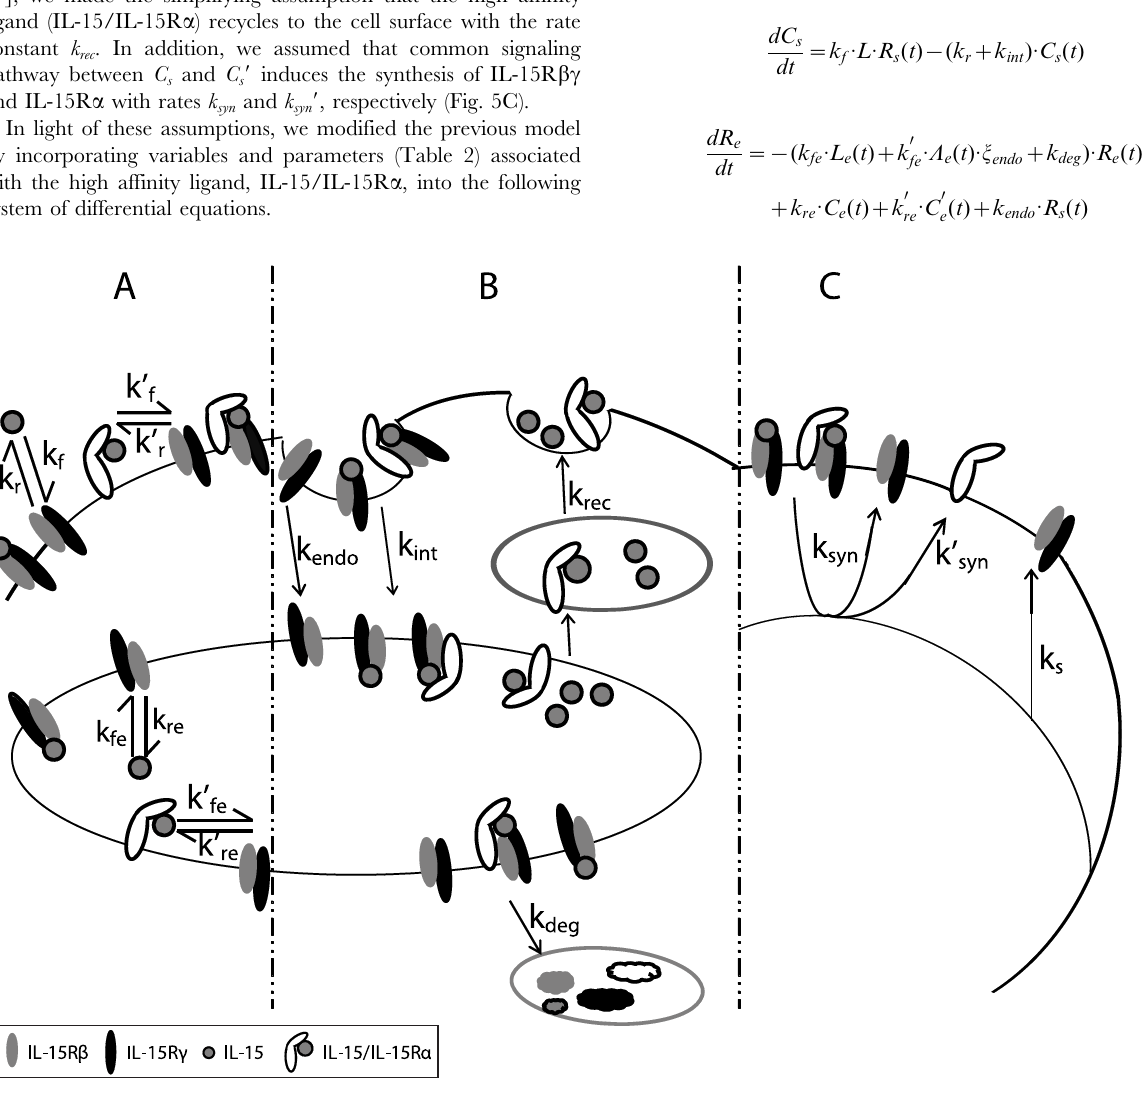
Figure 4. The quantitative influence of intermediate affinity binding model parameters on the steady state cell surface receptor and complex numbers. Model simulations were performed with the value of the parameter of interest varied by a factor of 1 and 100, while the values of all other parameters were held constant. Changes in cell surface receptor and complex numbers as a result of variations in parameter values are shown. Receptor and complex numbers corresponding to different values of the parameter of interest are shown by the dashed curves (with the arrow representing increasing values of the parameter being varied) while the solid curves represent the parameters at their original values. Simulations were performed for model parameters k f ( A ), k r ( B ), k f and k r ( C ), k endo ( D ), k int ( E ), k s ( F ), and k syn ( G ) at an IL-15 concentration of 25 ng/ml. Large increases ( . 10-fold) in k syn resulted in large perturbations in receptor and complexes numbers (data not shown).